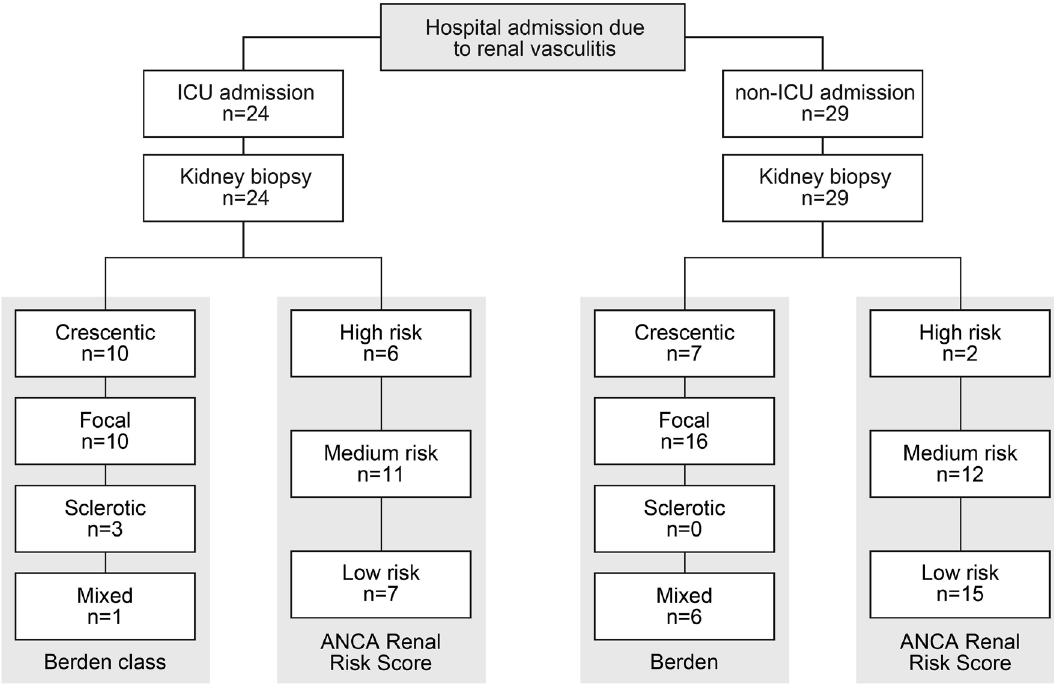
Figure 1. STROBE flow chart of the total patient cohort of biopsy-proven ANCA-associated renal